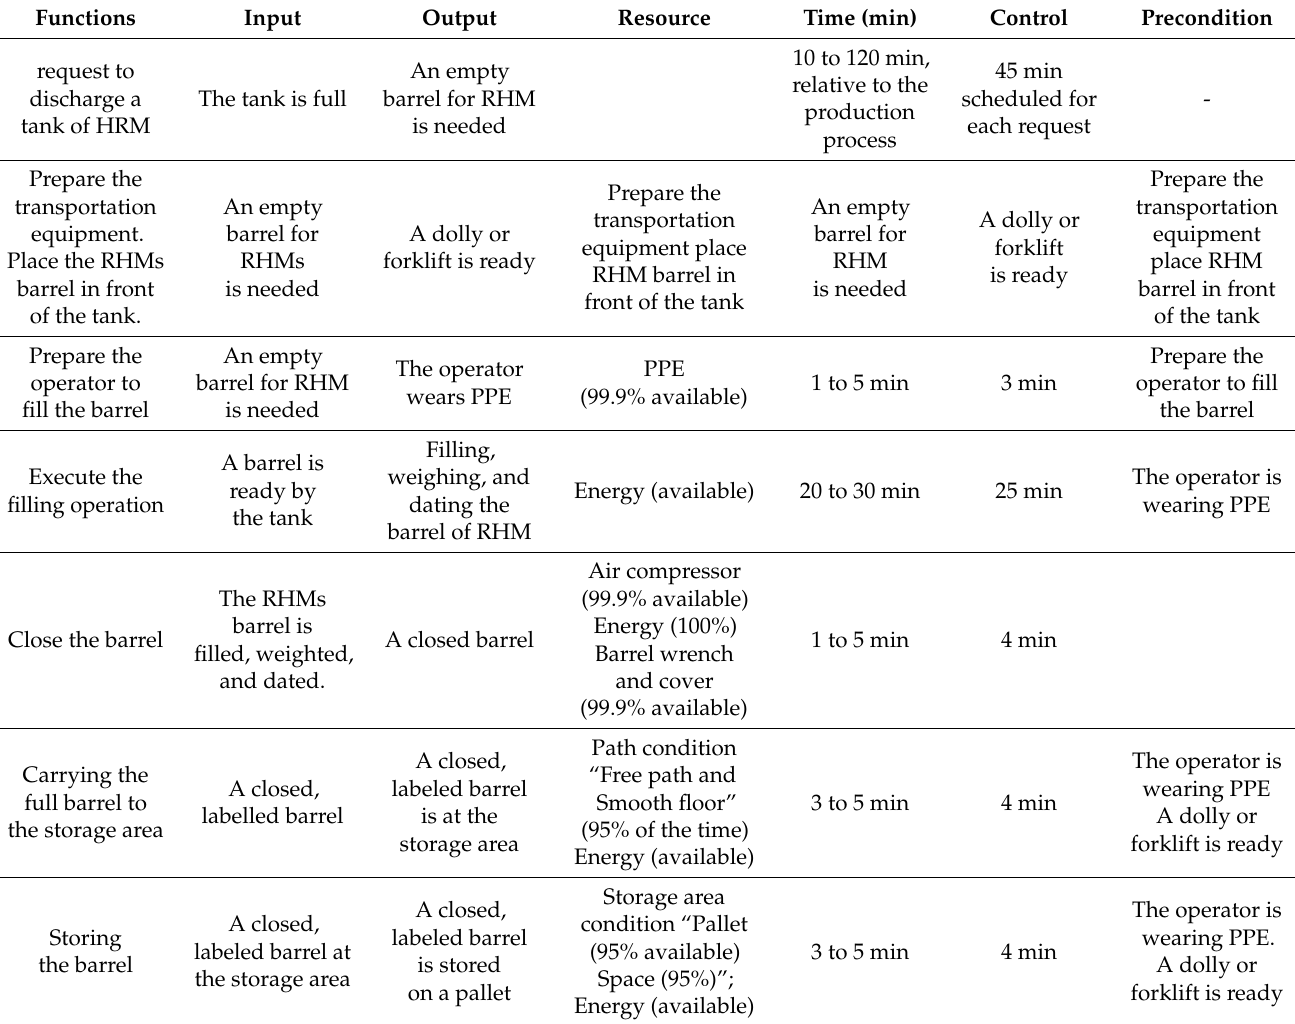
Table 1. The important features of the discharge, transport, and storage of HRM functions via the FRAM in